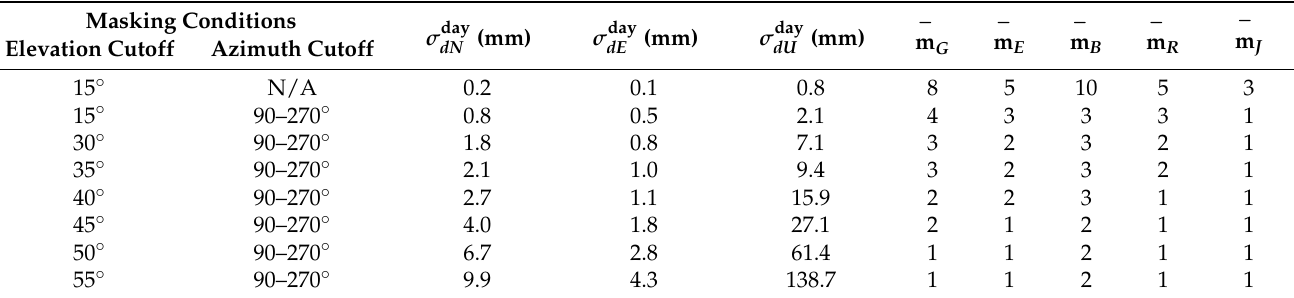
Figure 6. Distribution of standard deviations for 52 daily solutions. The left column is in an open-sky situation, and the right column is in a severely obstructed situation (azimuth cutoff is from 90 ◦ to 270 ◦ , and the elevation cutoff angle is 55 ◦ ). The red lines are the averages. Table 2. Standard deviations of the first daily solution and the average of the number of visible satellites for 52 days. m ∗ ( ∗ = G , E , R , B , J ) refers to the average of the number of visible satellites for each constellation. The averages have been rounded off.